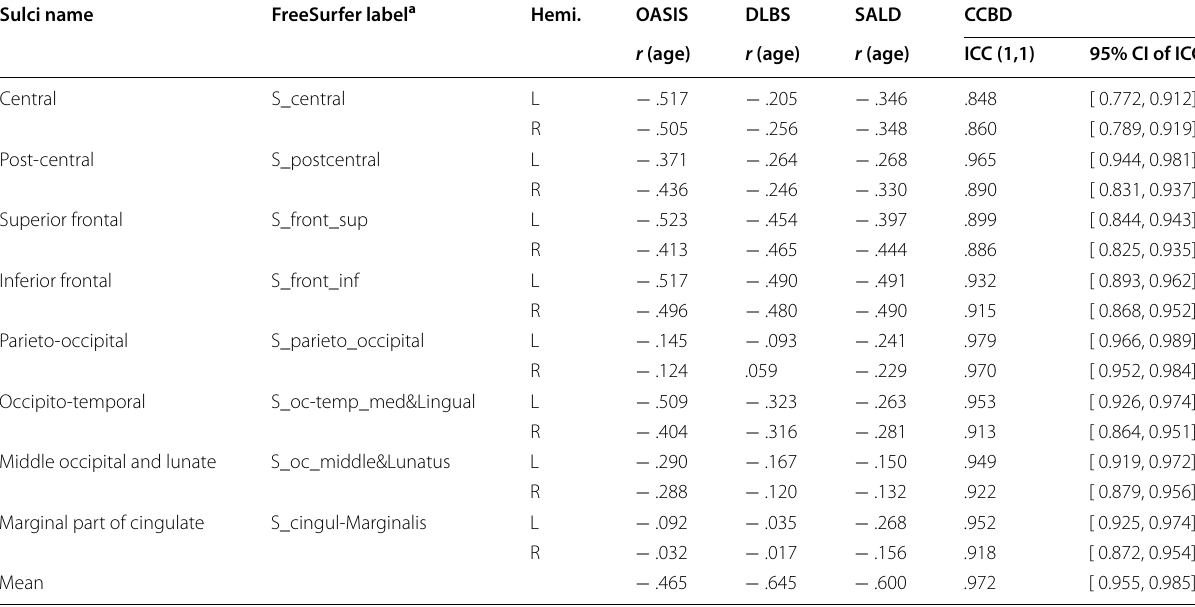
Table 2 Correlations between sulcal depth and age for each sulci and hemisphere, for each of the three lifespan datasets